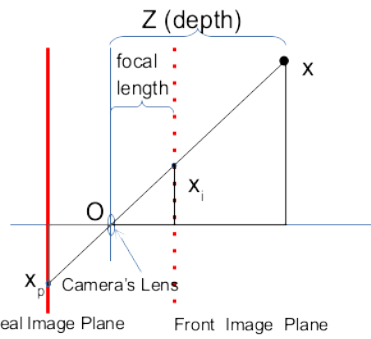
Figure 1. Pinhole camera’s projective